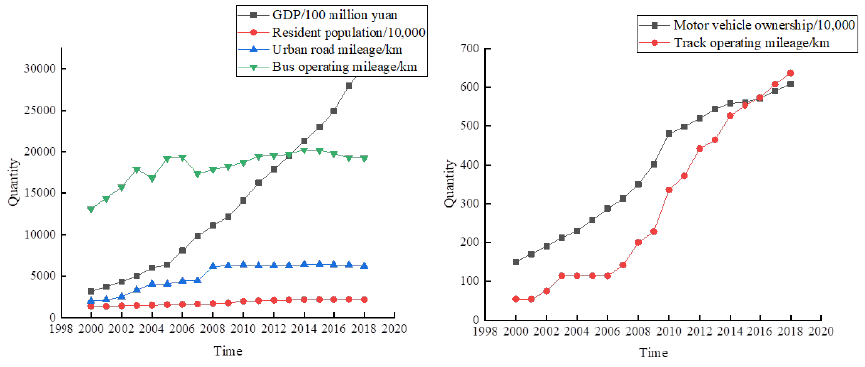
Figure 5. The numerical volatility of influencing factors.